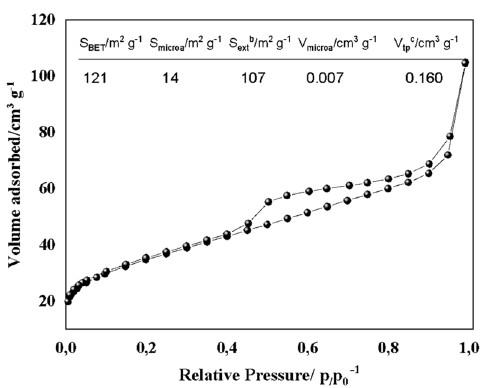
Figure 7. N 2 adsorption isotherms of the BG-Carb and textural properties of BG-Carb. Where: ( a ) Obtained by t-plot method; ( b ) S ext (external surface) calculated by the subtraction S BET —S micro ; ( c ) Total pore volume obtained at p/p0 =